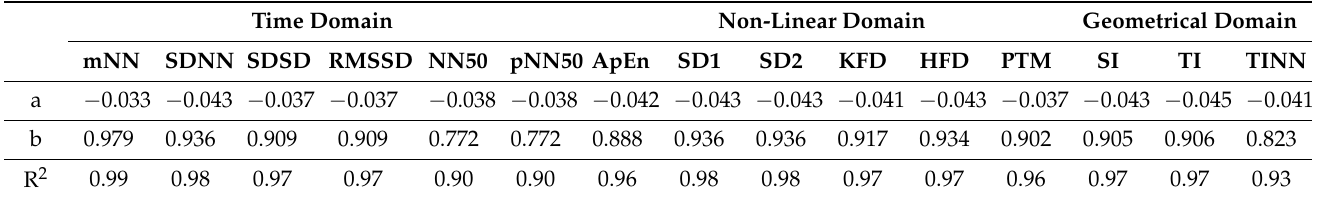
Table A4. Spearman’s Correlation Test—Linear Regressions of the Mean Correlations (subpart 1).